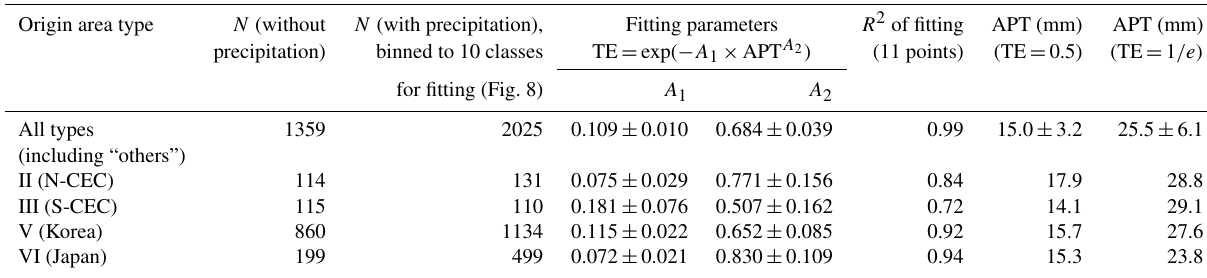
Figure 8. (a) Observed (cid:49) BC /(cid:49) CO ratios as function of APT. Raw data (gray plus signs) and 10 bins sorted by APT (black open circles) are shown. (b) TE as function of APT for overall cases (black open circles) and for individual air mass origin types (color circles and plus signs). Plus signs indicate air mass types for which large amounts of data are included (see Table 3). Only 10 bins sorted by APT are shown. Table 3. Results for fitting TE as function of APT for overall data and classified air mass